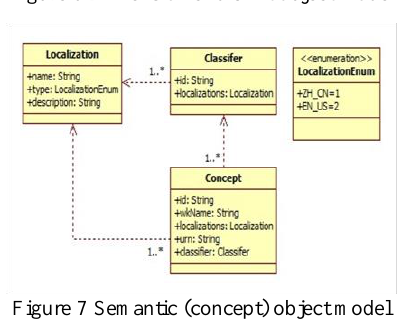
Figure 6 Dimension and Unit object model